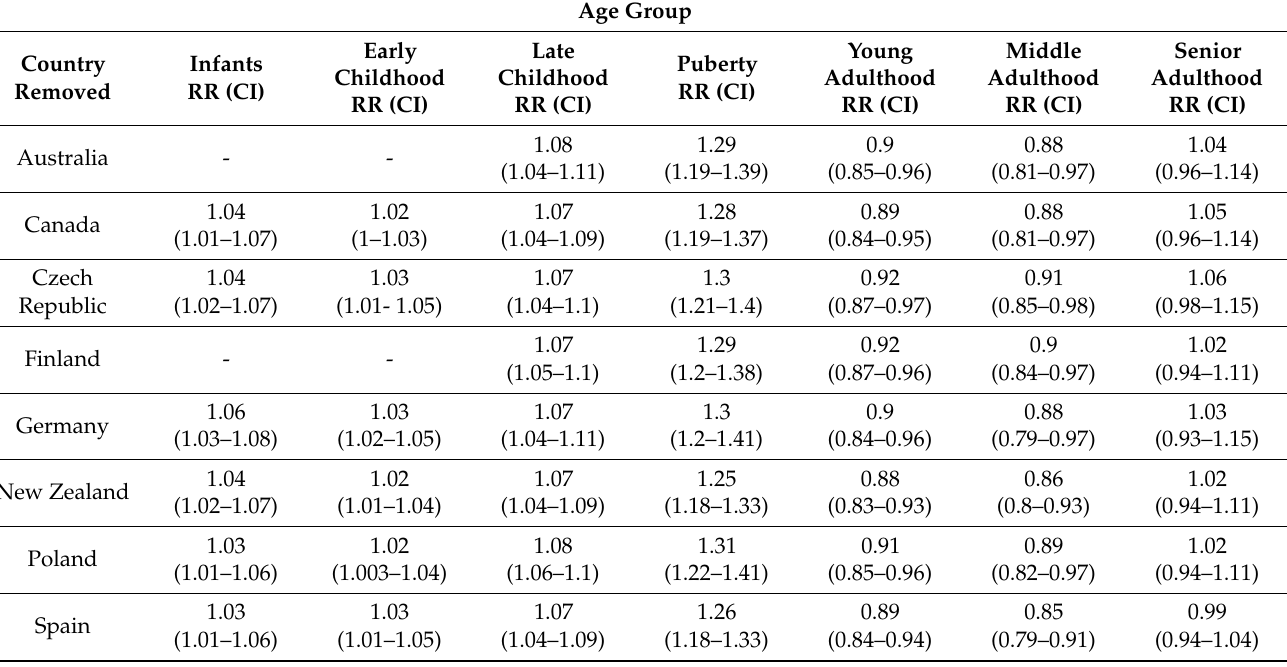
Table 2. Sensitivity analysis, by age group and country.